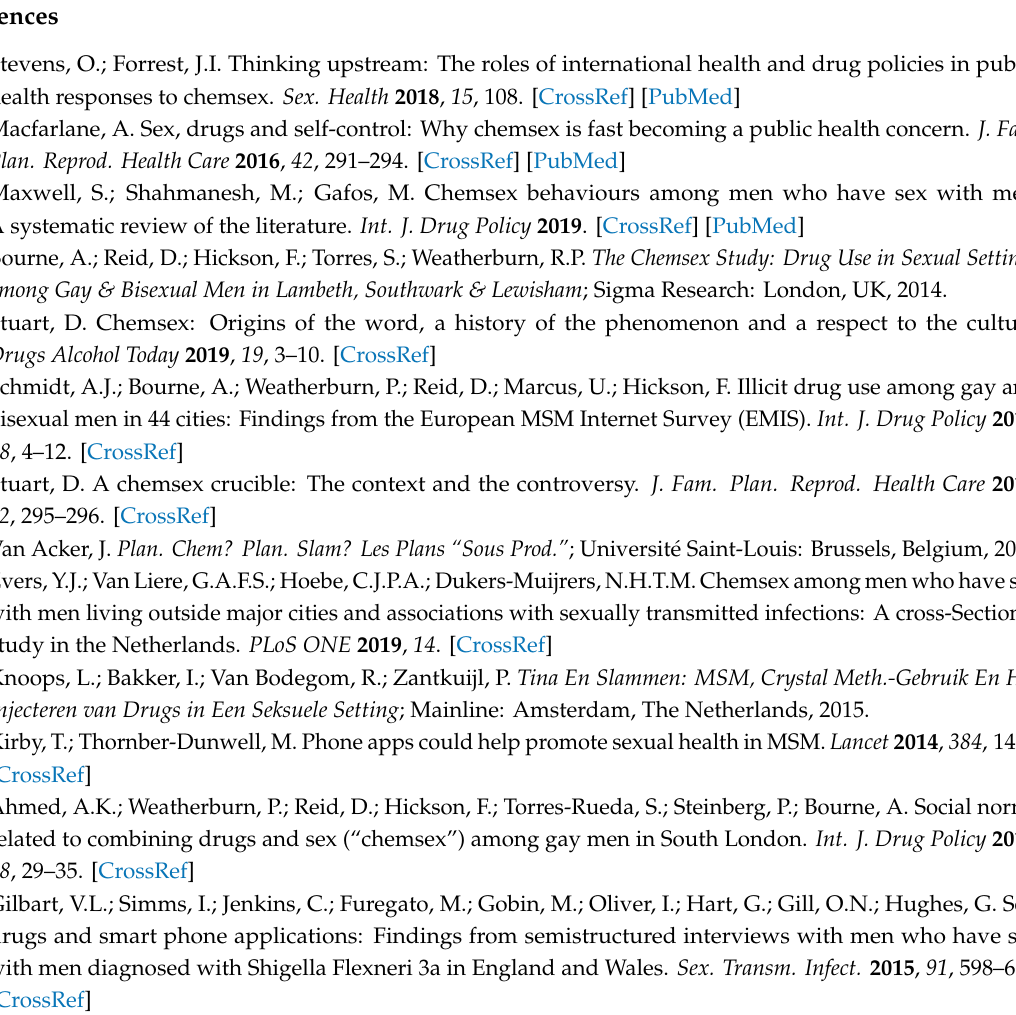
Table S1. Matrix, Questionnaire S1: Interview